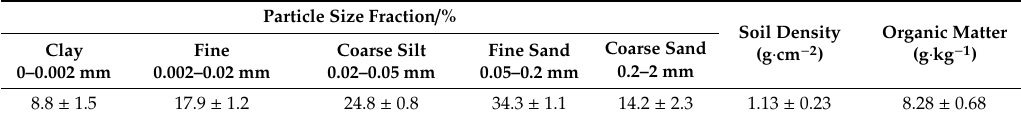
Table 1. Physical and chemical properties of the field